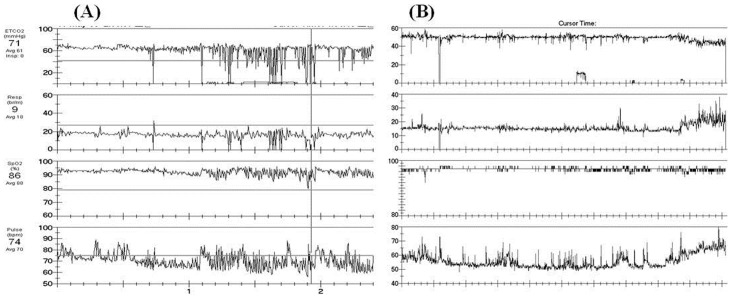
Capnography recording for patients with ALS.(A) Capnography recording showing intermittent desaturation and (B) no intermittent desaturation. Illustrated in descending order: ETCO2 (Top), respiratory rate, SpO2, and pulse (Bottom).